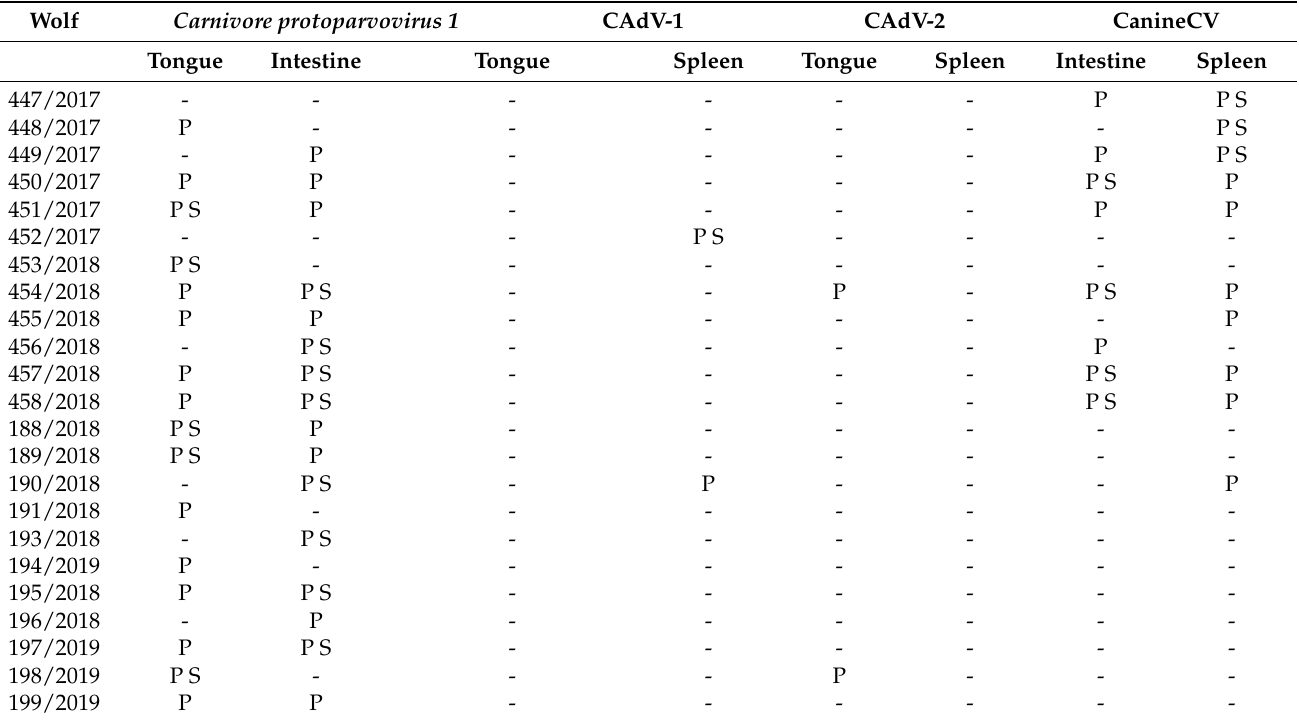
Table 2. Results of the Carnivore protoparvovirus 1 , Canine adenovirus type 1 and 2 (CAdV-1 and CAdV-2), and Canine circovirus (CanineCV) DNA